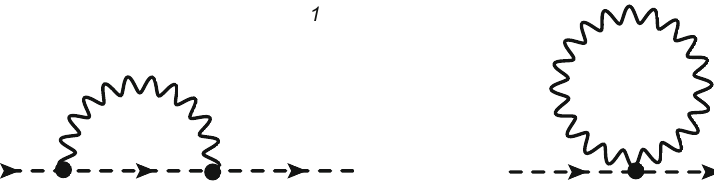
Fig. 4 One-loop Feynman diagrams contributing to the two point Green’s function (cid:7) u α 1 μ ( q 1 ) u α 2 ν ( q 2 ) (cid:5) . A wavy (dashed) line represents gluons (gluinos). The “double dashed” line is the ghost field. Only the first three diagrams appear in DR